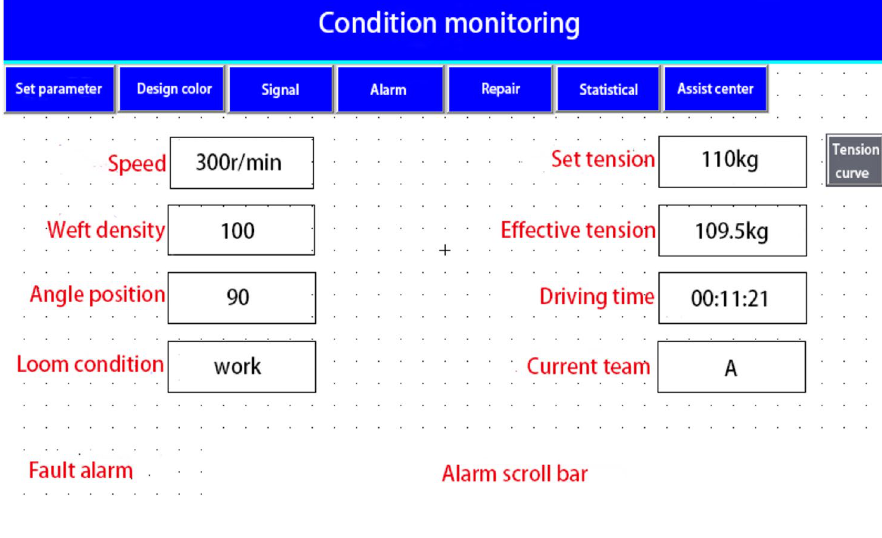
Fig. 19 Condition monitoring interface